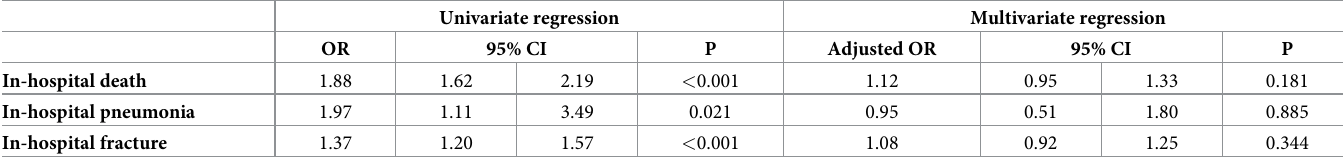
Table 4. Results of multilevel logistic regression analysis for in-hospital death, in-hospital pneumonia, and in-hospital fracture among people with and without dementia (n =